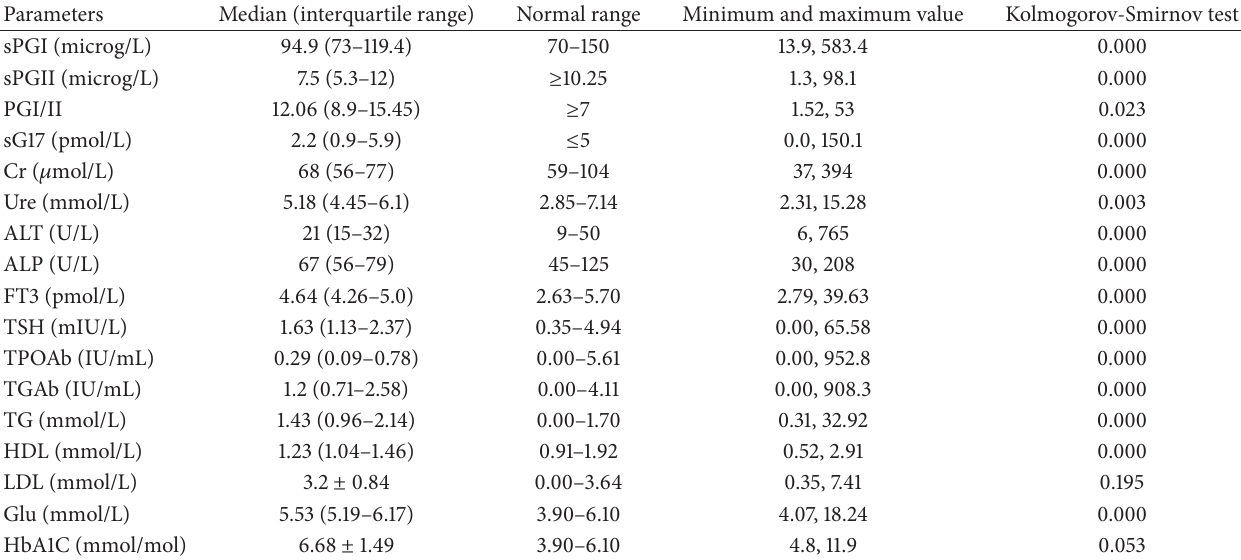
Table 1: Baseline